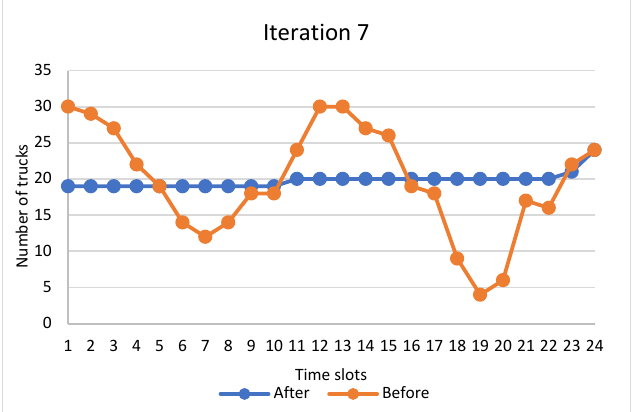
Figure 13. The workload before and after applying balancing constraint on iteration 7.